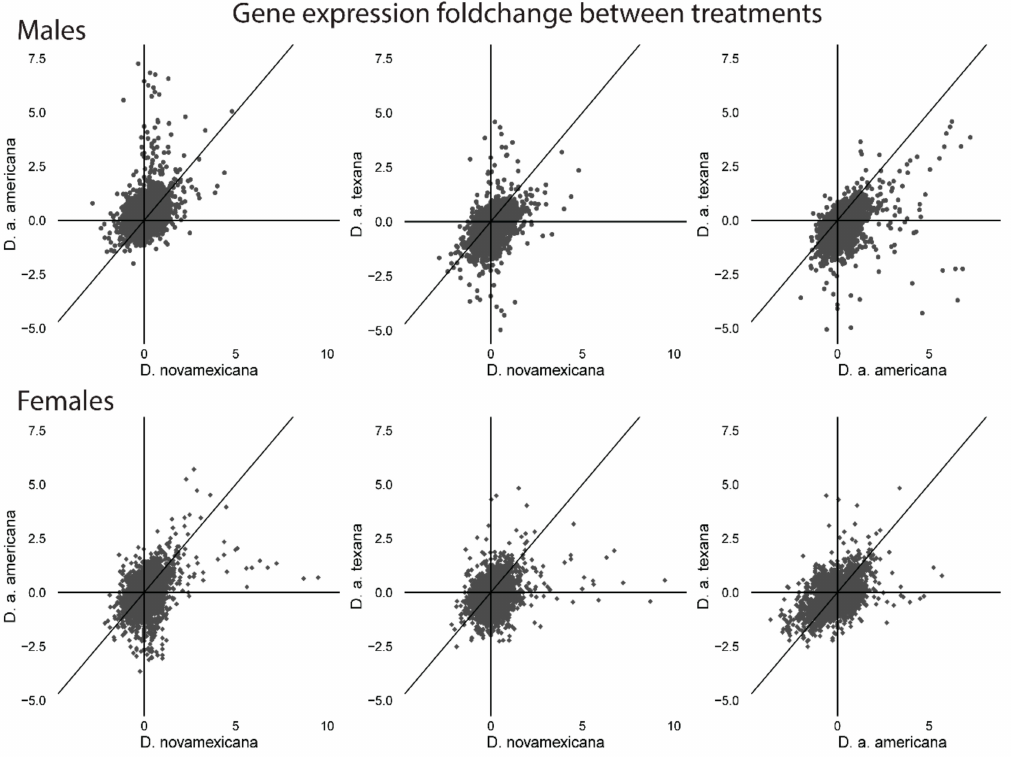
Figure 3. Pairwise species comparisons of (log 2 fold) gene expression di ff erences between ambient (non-desiccating) and desiccation conditions, for males (top) and females (bottom). Each point shows the expression change for one gene for each pair of species; diagonal lines are y = x and represent the expectation if species share an identical plastic response to desiccation stress. Points that lie far from this line indicate genes that have greater di ff erences in plastic expression patterns between